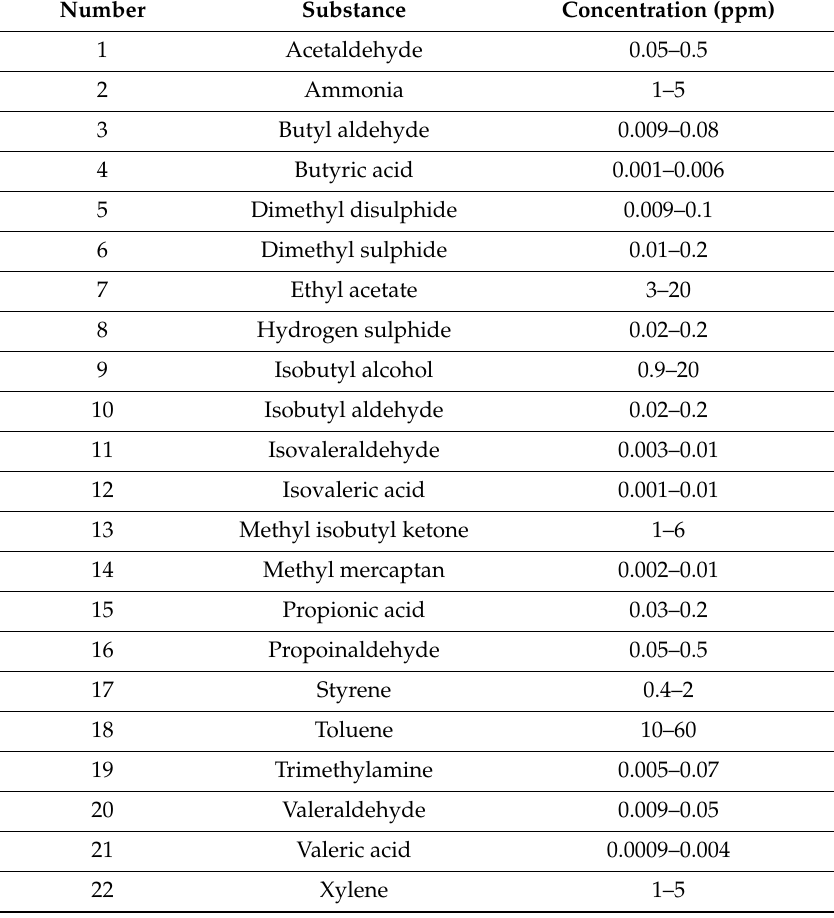
Table 4. Permissible contents of odour-generating substances in Japan (adapted from